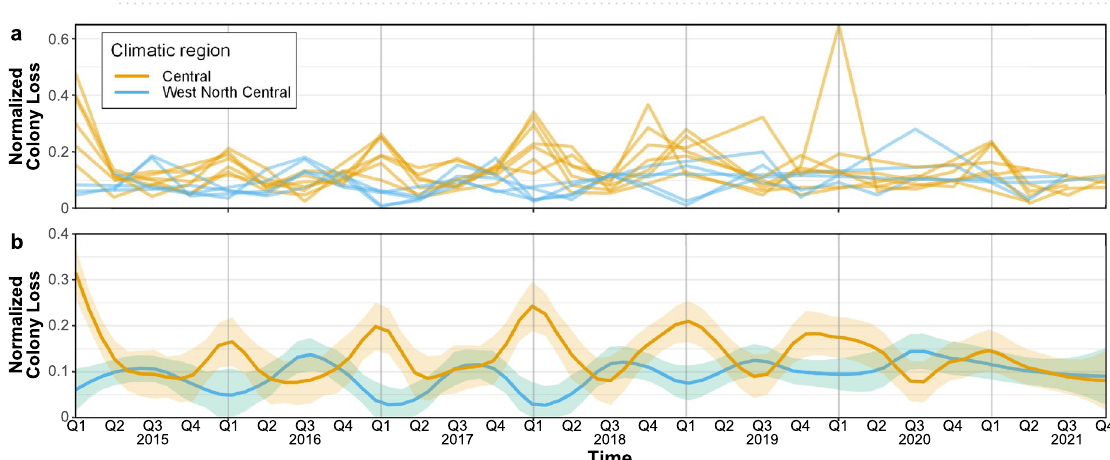
Figure 3. Comparison of normalized honey bee ( Apis mellifera ) colony loss (number of lost colonies over the maximum number of colonies) between Central and West North Central climatic regions for each quarter of 2015–2021 (the first quarter being January-March). ( a ) Trajectory of each state belonging to Central (yellow) and West North Central (blue) climatic regions. ( b ) Smoothed conditional means for each of the two sets of curves based on a locally weighted running line smoother where the width of the sliding window is equal to 0.2 and corresponding standard error bands are based on a 0.95 confidence level 46